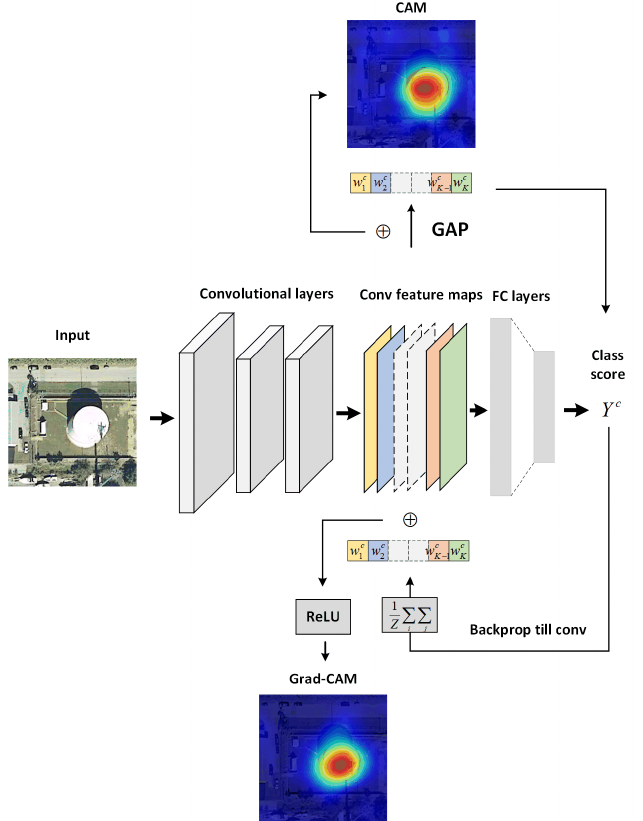
Figure 2. The flow chart of the class activation map (CAM) and gradient-weighted class activation map